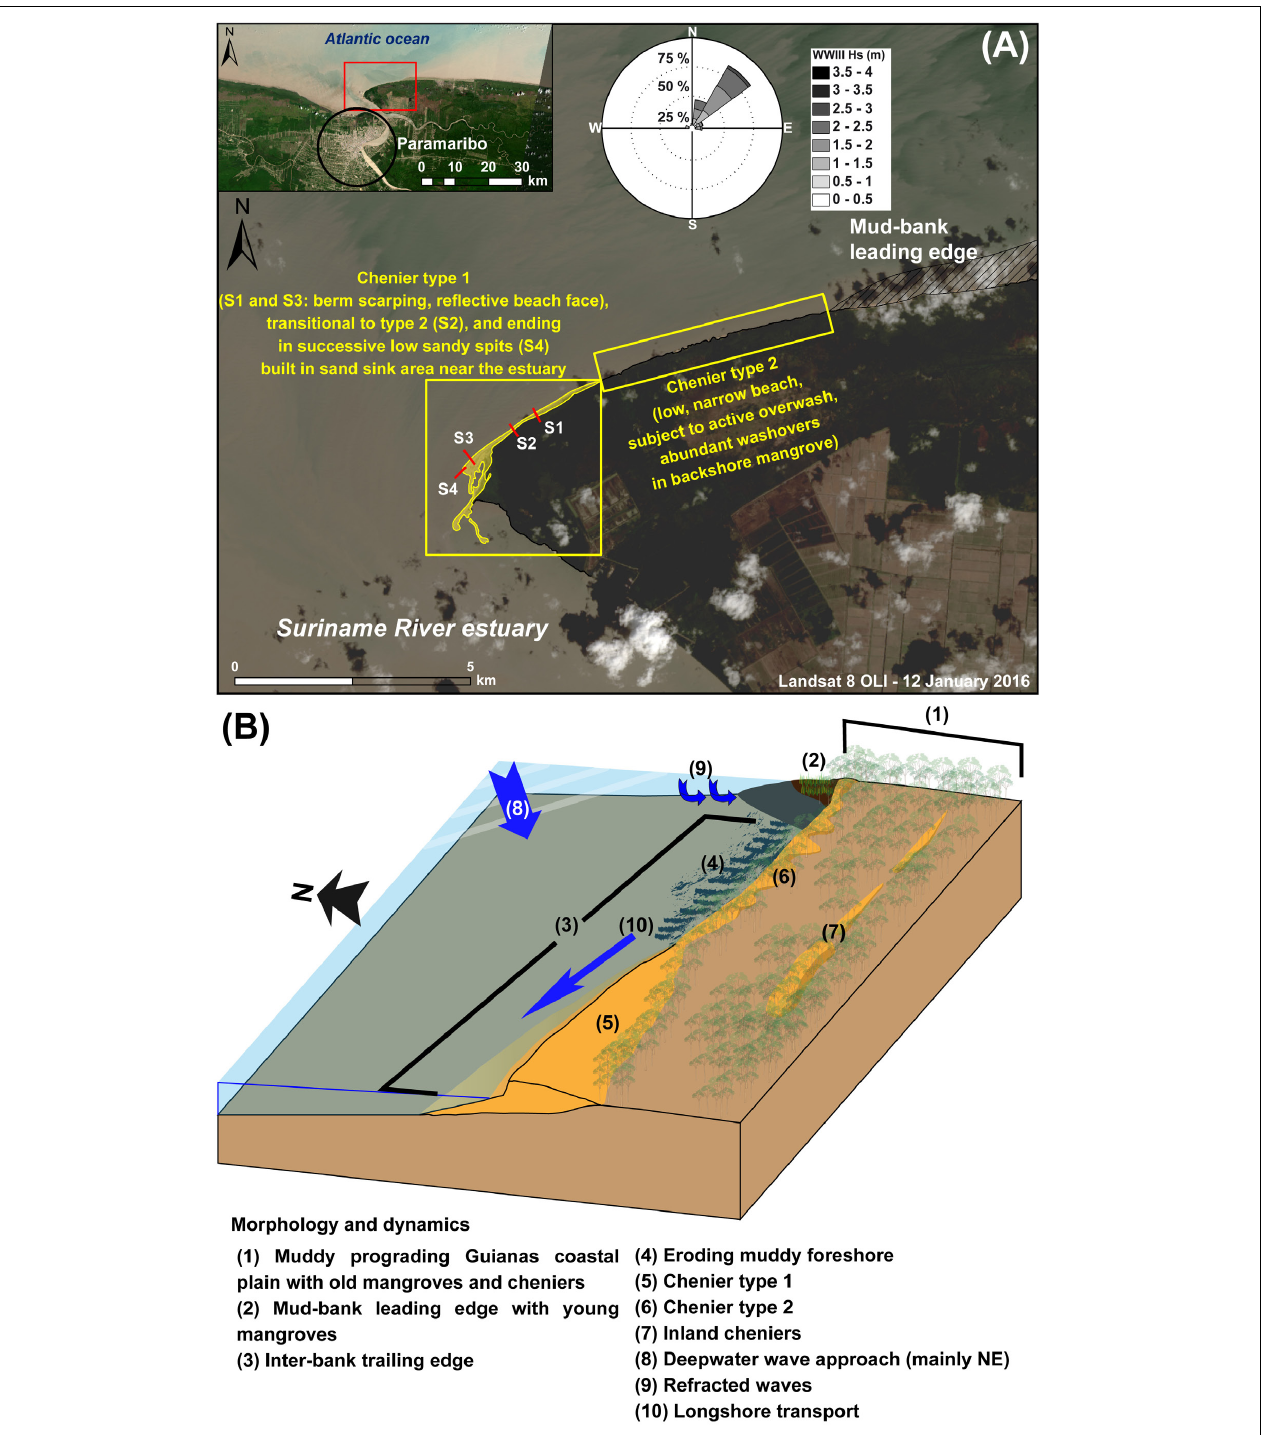
FIGURE 12 | A synthesis superimposed on a 2016 Landsat image (A) , and a conceptual model (B) of the morphodynamics and sediment transfer conditions at Braamspunt beach. S1 to S4 are representative of profiles 1 to 4 ( Figure 10 ). The type 1 chenier regime is characterized by a well-developed, albeit eroding berm with overwash processes less well-expressed, and conforms to a beach dominated by dissipative-to-reflective processes. The type 2 chenier regime is dominated by overwash processes and eventual partial break up where local variations in incident wave energy occur. Mangrove colonization accompanying bank phases commonly mask cheniers, a preliminary phase to their isolation inland (B)